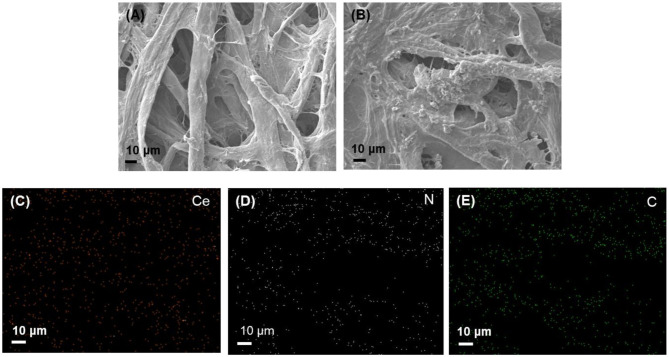
SEM images of (A) bare paper strip, (B) paper strip incorporating both nanoceria and ChOx, and the corresponding EDS maps of (C) Ce, (D) N, and (E) C elements.